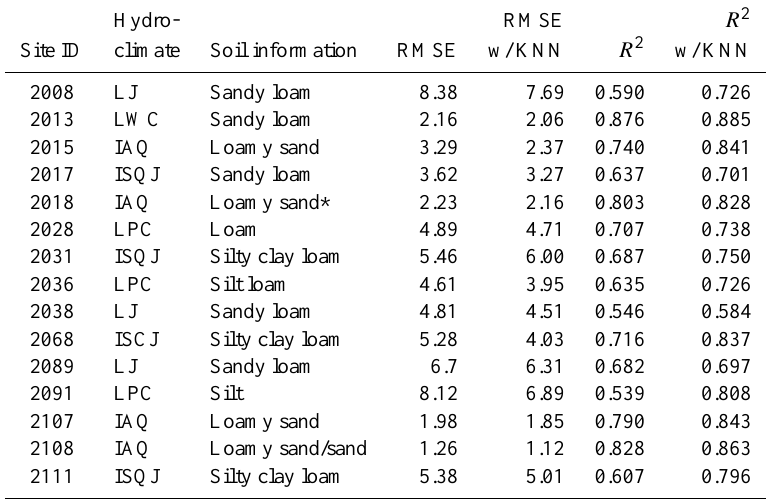
Table 1. The 15 SCAN sites: class and soil information and performance. Hydro-